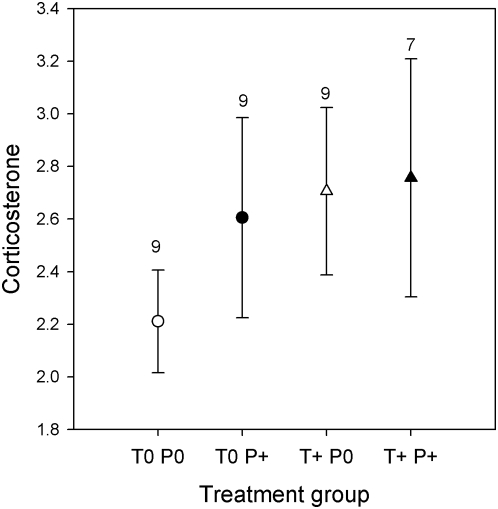
Mean±s.e. levels of corticosterone (pg / mm) in feathers of red grouse according to hormone and parasite treatments.T0: control implanted; T+: testosterone implanted; P0: purged of worms; P+: challenged with T. tenuis infective larvae. Numbers above bars are sample sizes.